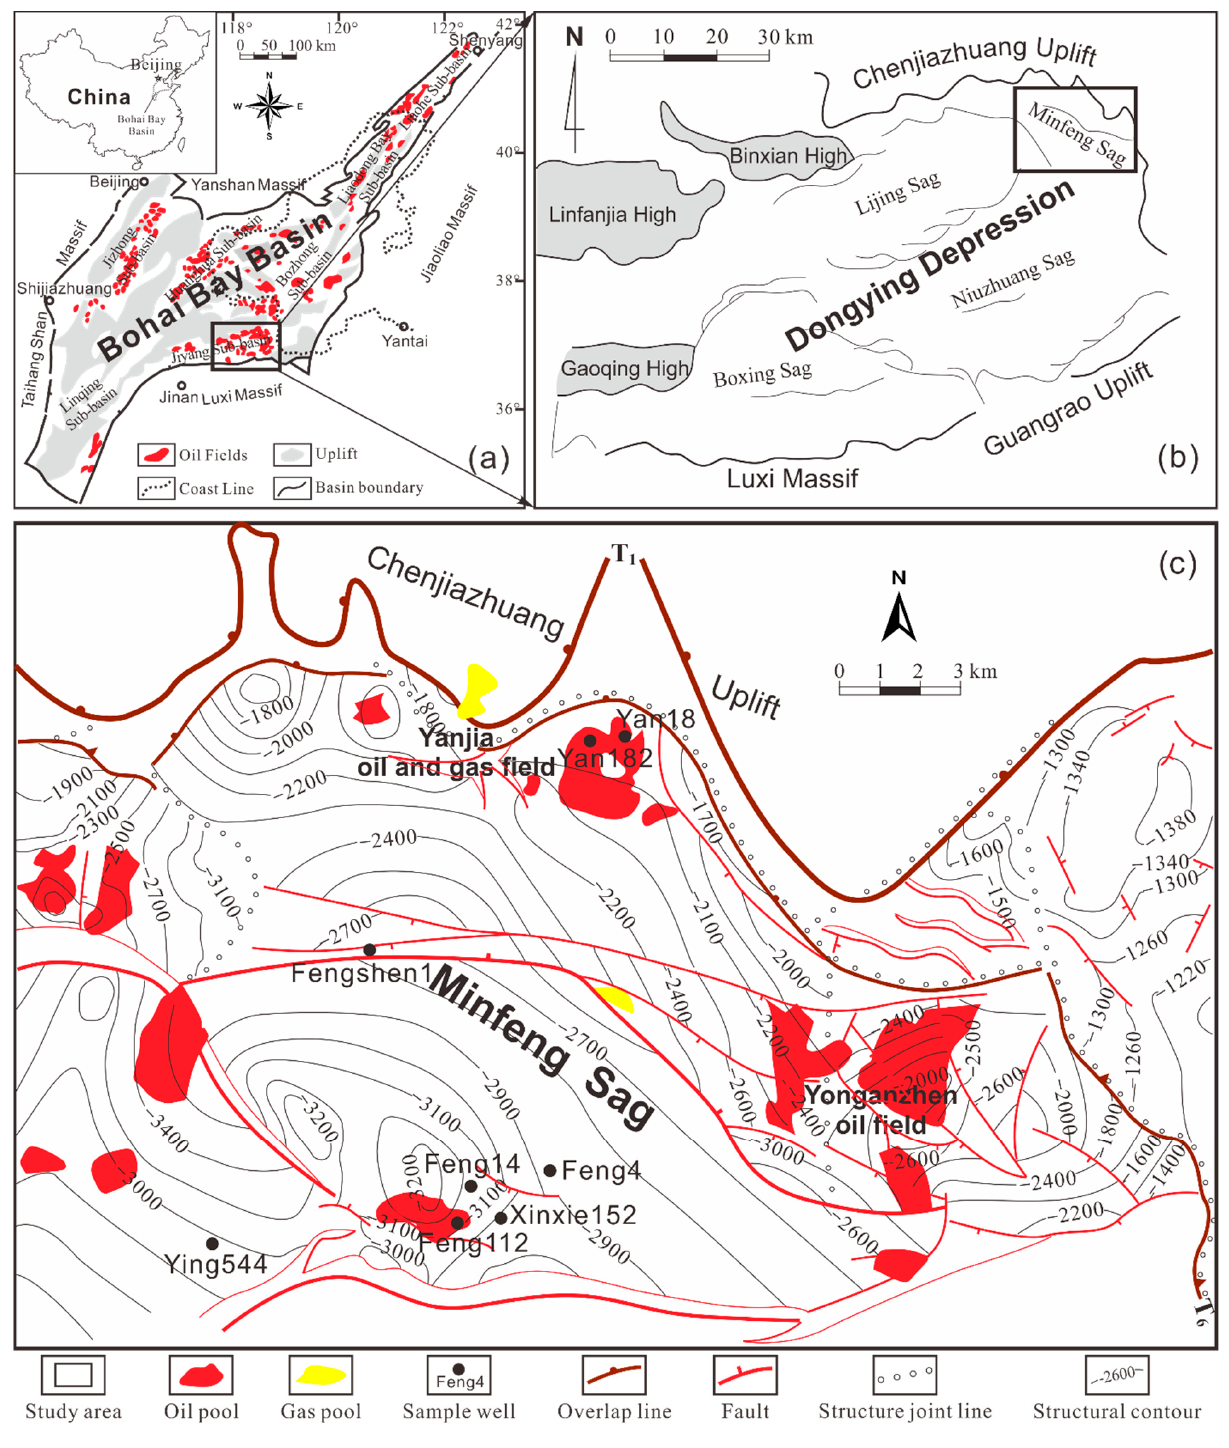
Figure 1. Geological maps showing the location and regional structure setting of the Minfeng sag. (a) Location of the Dongying depression in the Bohai Bay Basin; (b) Location of the Minfeng sag in the Dongying depression; (c) Structural map of the Minfeng sag and the distribution of sampling wells.